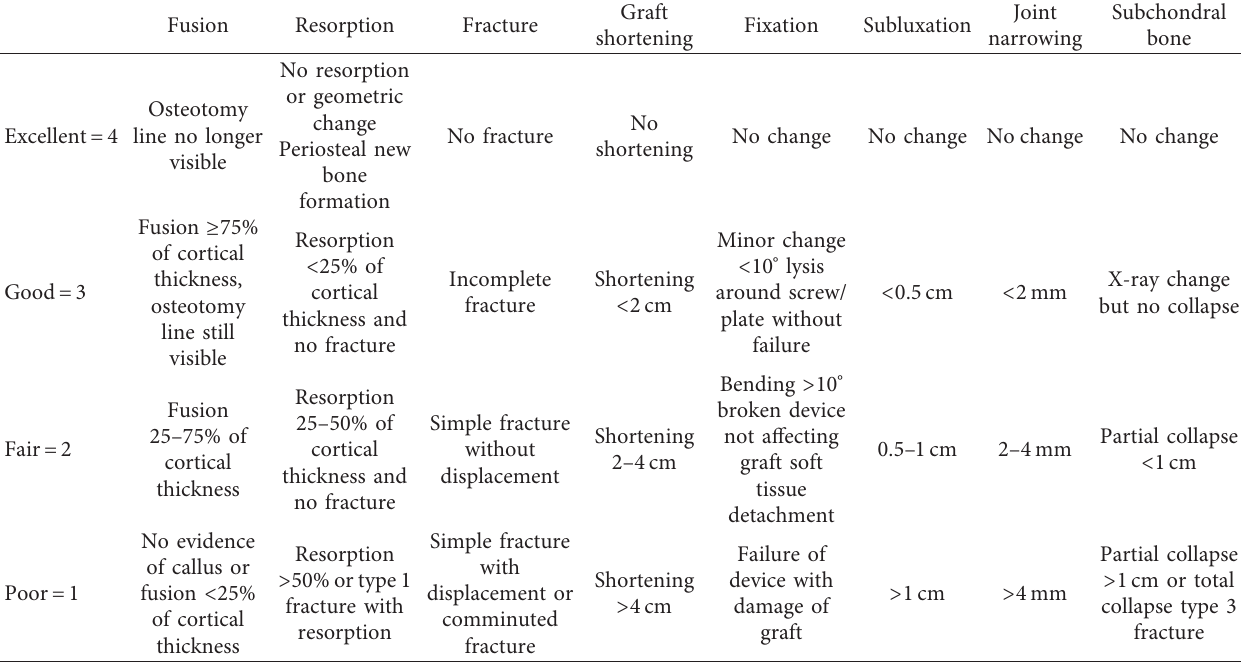
Table 2: ISOLS radiographic evaluation form for osteoarticular graft.